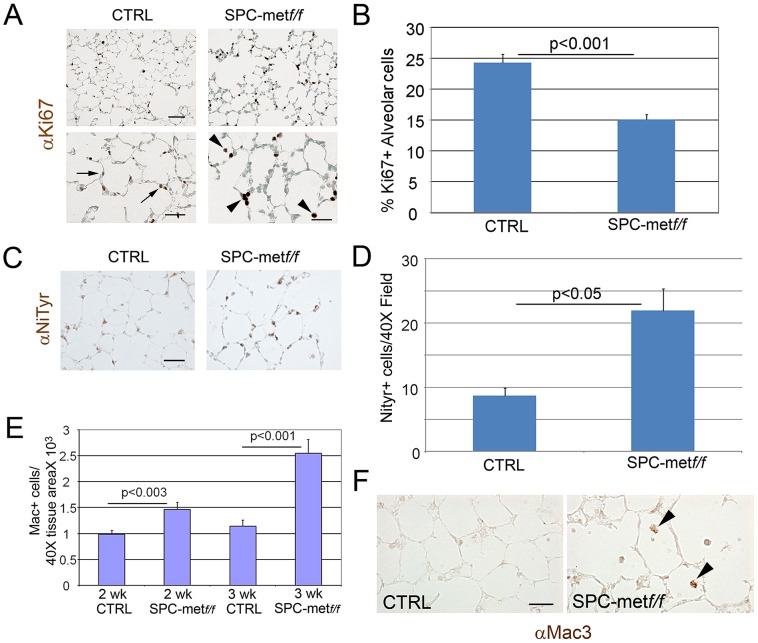
Increased oxidative stress, reduced alveolar cell proliferation, and increased inflammation in lungs of Met–deficient mice.A. Representative immunohistochemical staining for proliferation marker Ki67 in Met-deficient mice compared with controls. Arrows show increased alveolar cell proliferation in control lungs compared with mutant lungs. Arrowheads denote increased proliferation signal in alveolar macrophages in mutant lungs. Scale bar: 50 µm (top panel), 25 µm (bottom panel). B. Quantitative immunohistochemistry of Ki67 staining in the alveolar epithelium of Met-deficient mice and controls. C. Representative immunohistochemical staining (brown) for nitrotyrosine (NiTyr) in lungs of control and SPCMet
f/f mice. Arrowheads denote positive staining. 20× magnification. N = 4 mice per genotype. Scale bar: 50 µm. D. Quantitative immunohistochemistry of nitrotyrosine staining in SPCMetf/f mice compared with controls. E. Macrophage abundance per Mac3 immunohistochemistry in Met-deficient lungs and controls at 2 and 3 weeks of age. Note increasing macrophage influx in mutant lungs. N = 4–6 mice per genotype. F. Representative immunohistochemical staining (brown) for macrophages (Mac3) in lungs of control and SPCMet f/f mice at 3 weeks of age. Arrowheads denote positive staining. 40× magnification. N = 4–6 mice per genotype. Scale bar: 25 µm.